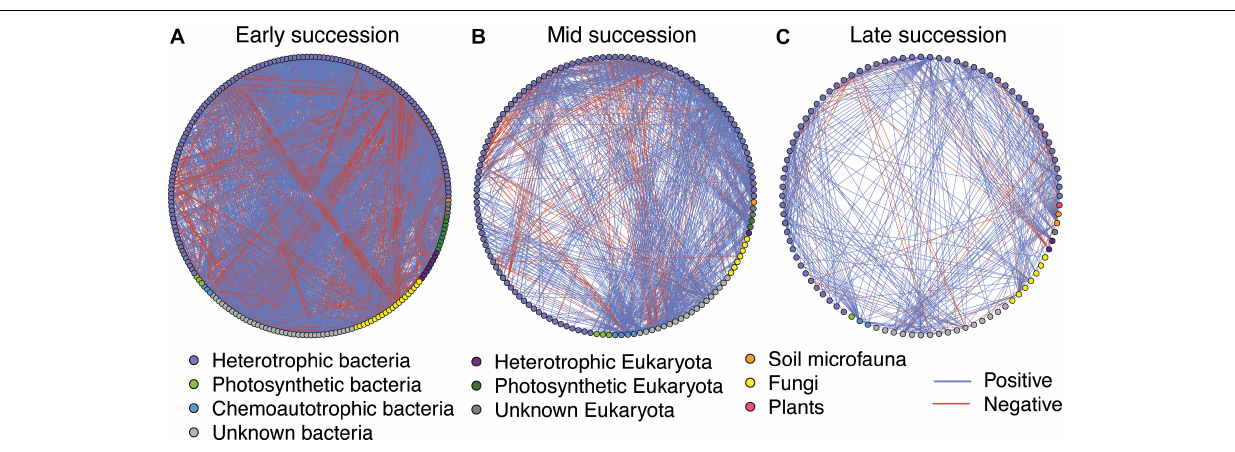
FIGURE 3 | Microbial networks across a successional gradient from early (A) , mid (B) , and late (C) successional stages. Interactions were assessed using the residual species-to-species correlation matrix from a hierarchical joint distribution model, which removes the effect of environmental covariates on species distributions. Displayed here are the correlations whose 95% credible intervals did not overlap zero. Nodes are colored based on taxonomy. See Table 2 for network